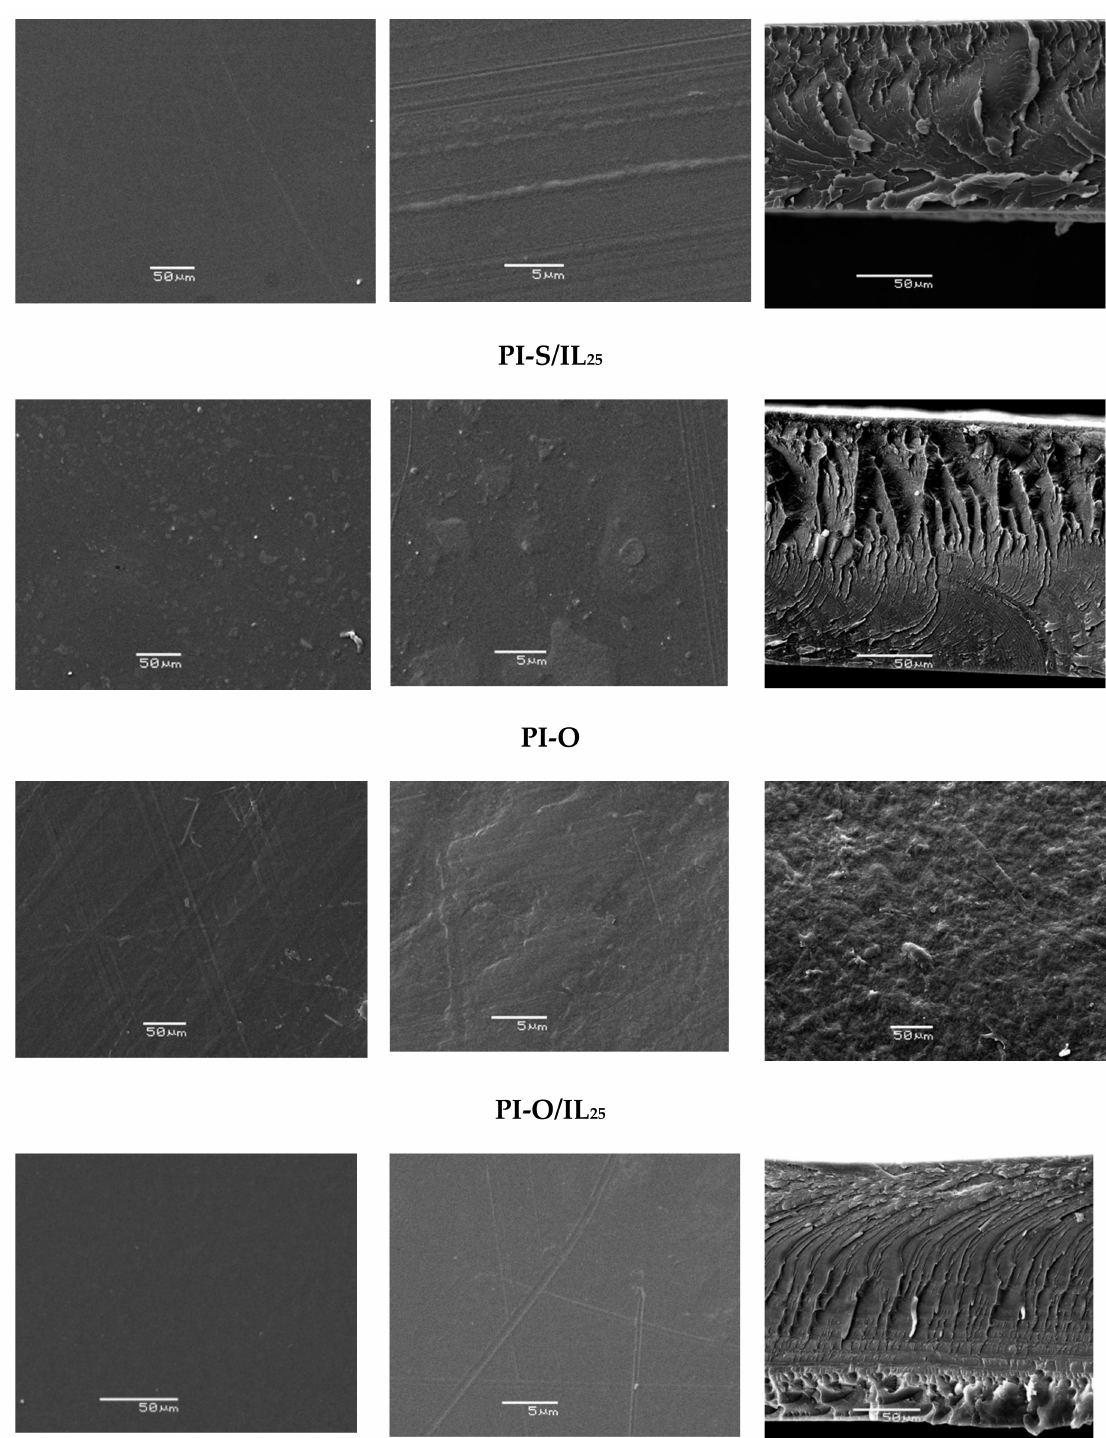
Figure 5. SEM micrographs of the PIs films and PI / IL 25 composite films. Left and central columns: surface micrographs. Right column: side view